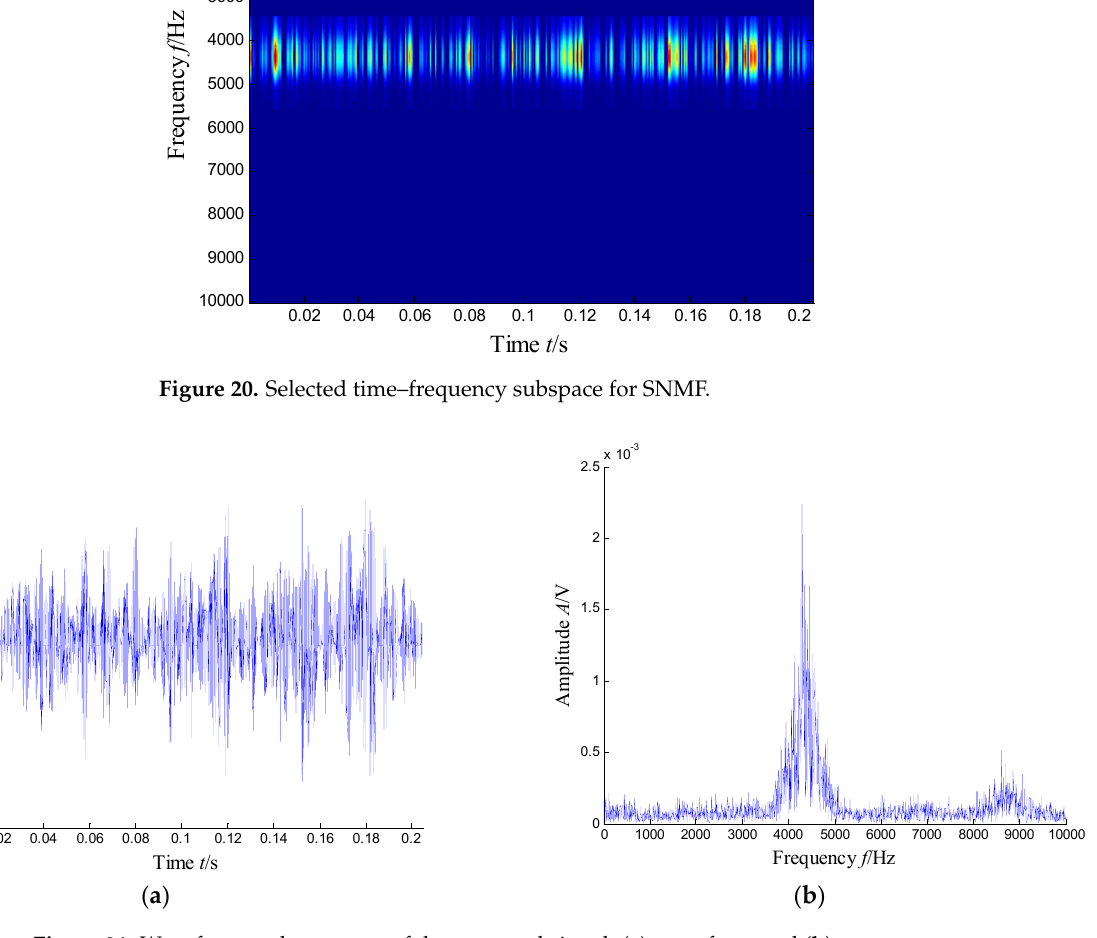
Figure 21. Waveform and spectrum of the extracted signal: ( a ) waveform and ( b ) spectrum.